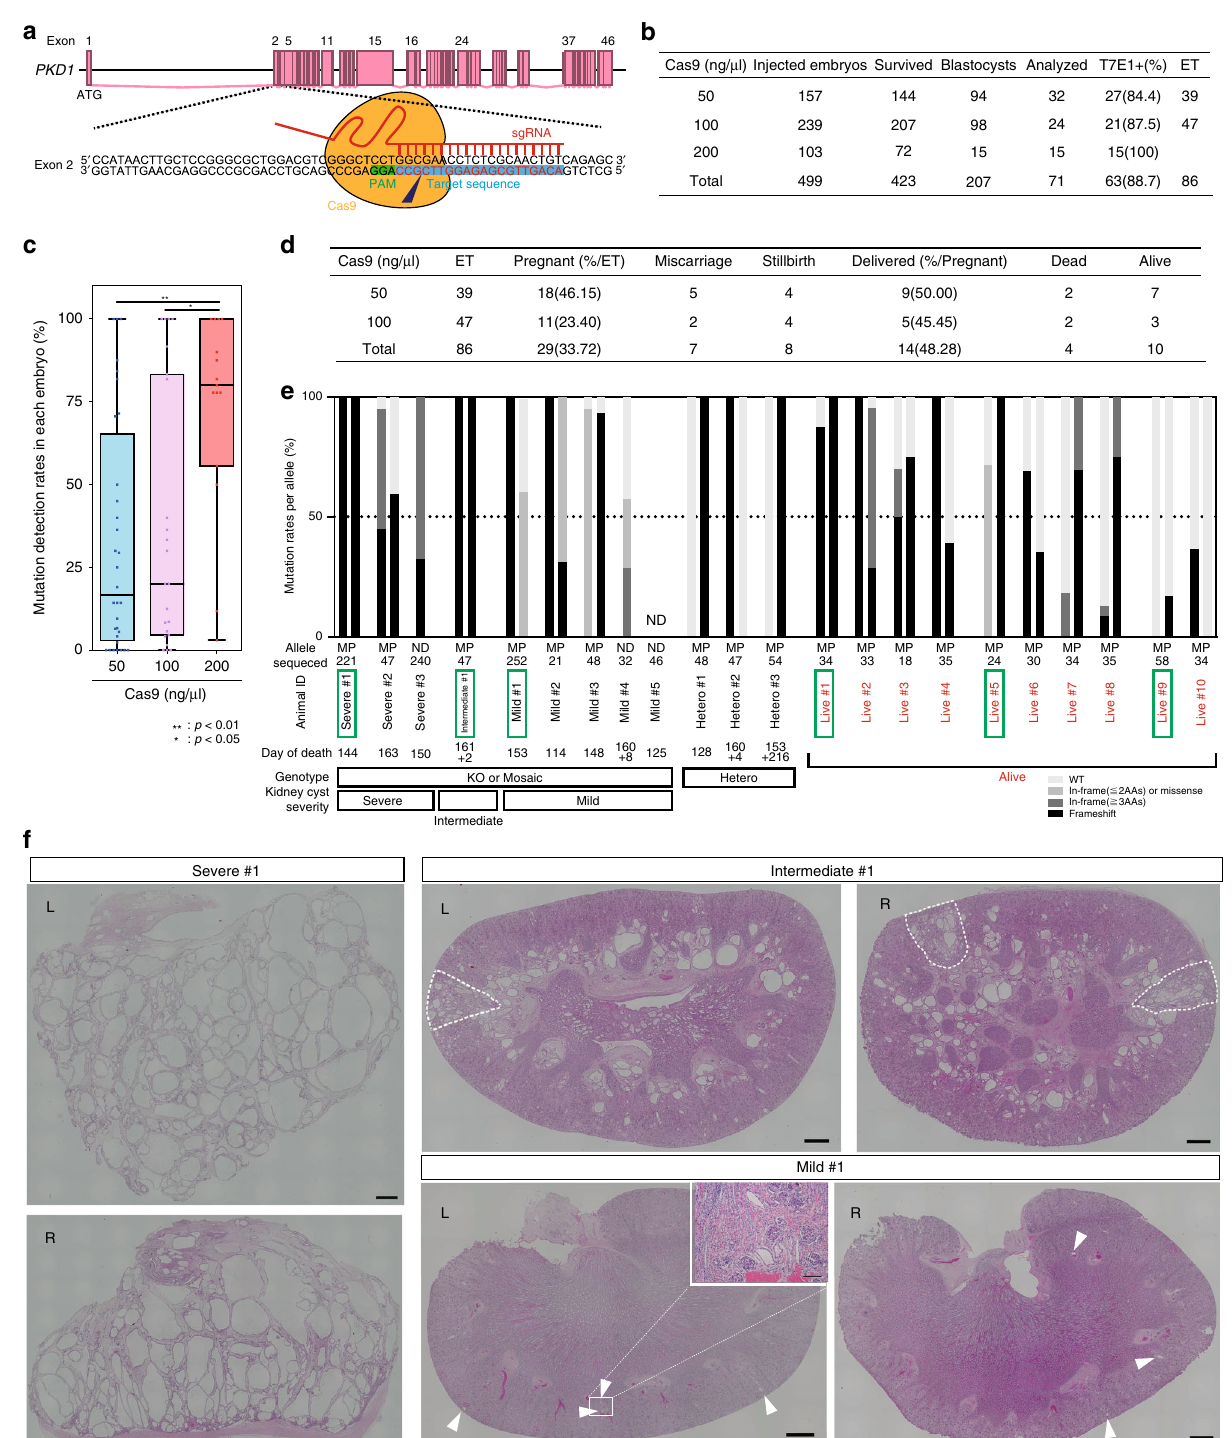
to early-stage ADPKD kidneys in human heterozygotes 28,29 (Fig. 1f, Supplementary Fig. 3). In monkeys with intermediate- type kidneys, it is noteworthy that there were several kidney compartments in which more than 30% of the area was fi lled with multiple cysts (Fig. 1f, the compartments surrounded by dotted lines), similar to monkeys with severe-type kidneys, while cysts in other compartments developed sporadically (Fig. 1f). This suggests that intermediate-type kidneys may constitute a transi- tional state between severe- and mild-type kidneys, since it had features of both. Collectively, although the phenotype is variable,